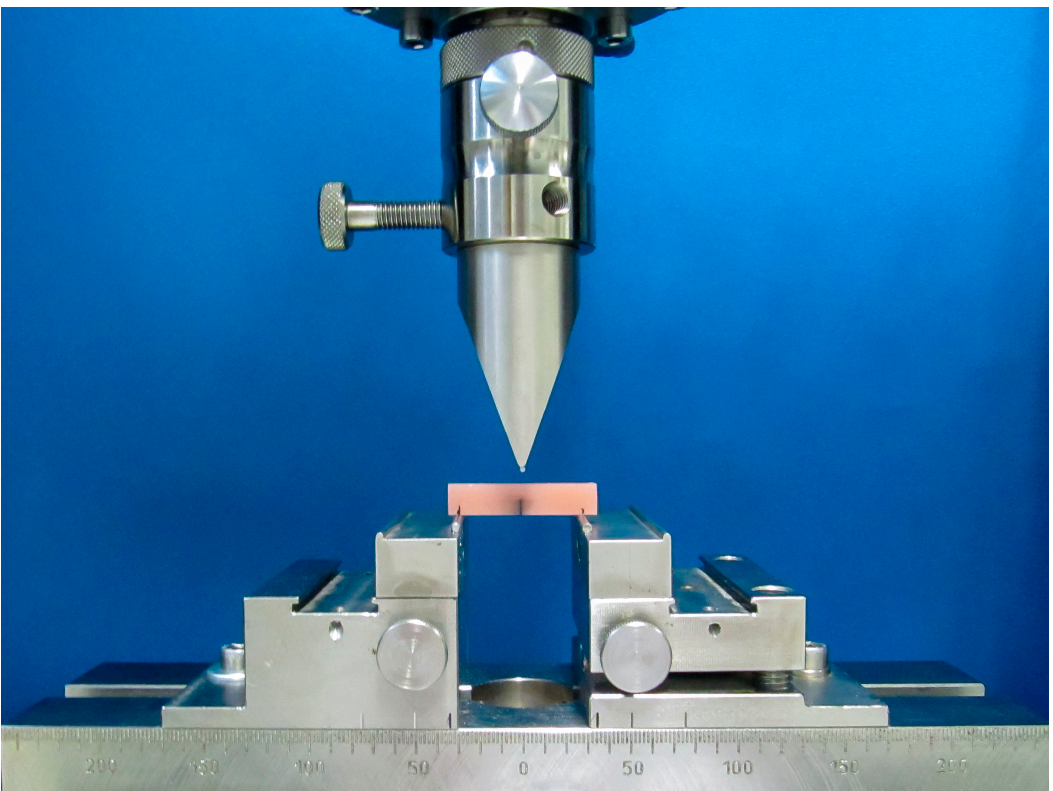
Figure 1. Experimental setup for the three-point bending test.